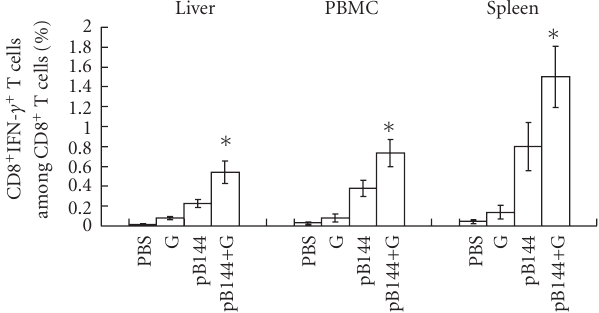
Figure 5: E ff ect of β -glu6 on the CD8 + /IFN - γ + T cells induced by pB144 in di ff erent organs. Mice were immunized with pB144 and treated with β -glu6, and boosted at day 30. Ten days after boosting, the liver lymphocytes, PBMC, and splenocytes were isolated and cultured for 5 hours in the absence or in the presence of a specific peptide corresponding to K b -restricted CTL epitope of HBcAg. Cells were then double-stained with PE-anti-CD8a and APC- anti-IFN- γ antibodies and analyzed cytofluorometrically. Data are expressed as mean ± SD of 3 mice/group. ∗ P < . 05, pB144+G versus pB144